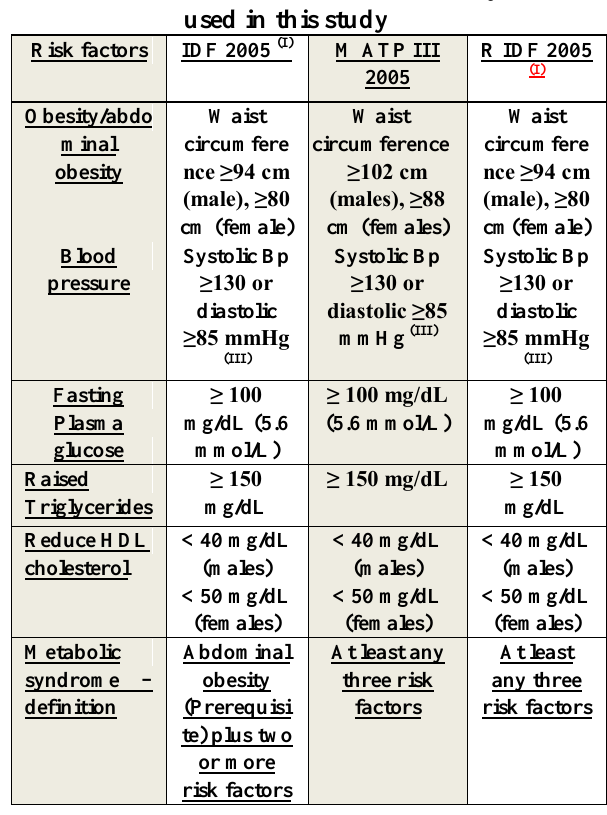
Table (2): The definitions of Metabolic